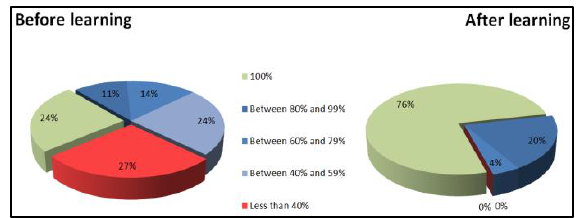
Fig. 6. Qualitative view of the scenarios‟